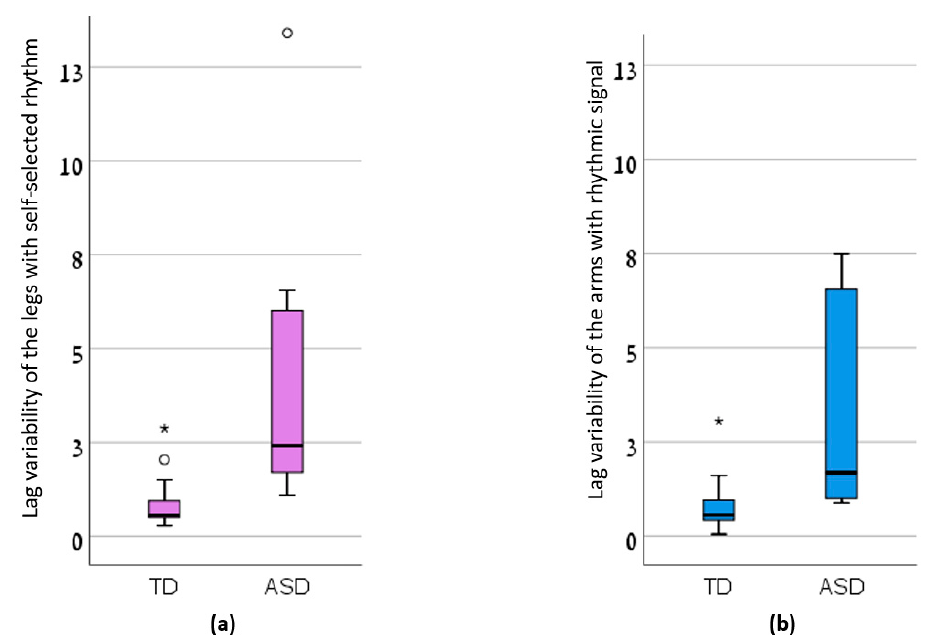
Figure 2. The lag variability of the ( a ) legs with self-selected rhythm and ( b ) arms with rhythmic signal in Typically Developed (TD) children and children with Autism Spectrum Disorder (ASD).